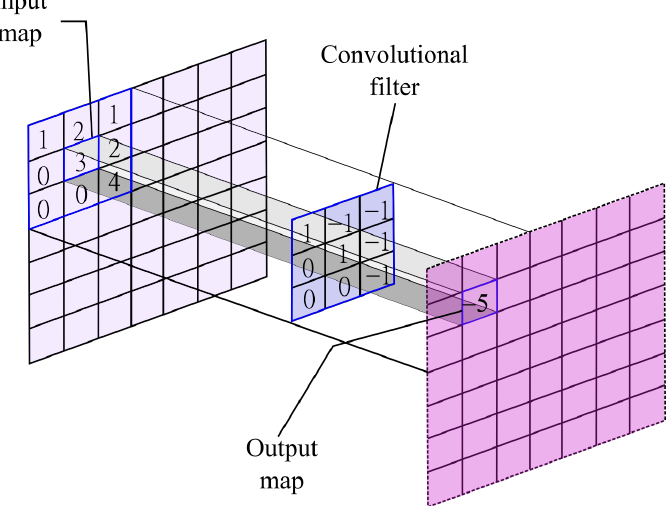
Figure 1. Example of a convolutional